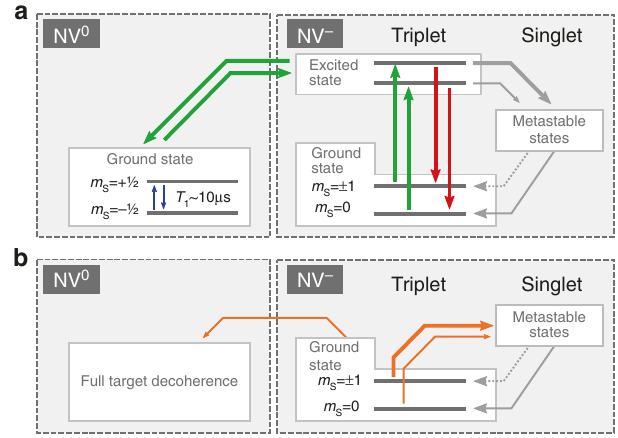
Fig. 7 NV level schemes for simulation. a Level scheme showing the relevant parts of negative and the neutral charge state of the NV center. In NV − , the two spin sub-levels show different fl uorescence intensities, as well as a spin polarization by an inter system crossing (ISC) into the metastable singlet state (here drawn as a “ black box ” ). Ionization occurs as an effective two photon process from the NV − ground state 37 , ending up in the uncharged NV 0 with a high-spin dissipation rate. Recombination also occurs as a two photon process. For the simulation of the pure NV − and NV 0 case, only the respective ground states are modeled. b The reduced level scheme for the simulation of the continuous excitation case. The NV − excited state is omitted due to its short lifetime. The spin-dependent ISC is realized by spin-dependent excitation rates. Ionization to the NV 0 charge state is implemented by immediate target spin